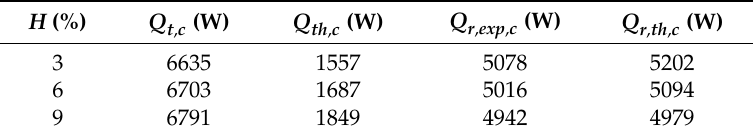
Table 6. The heat exchanges with different opening